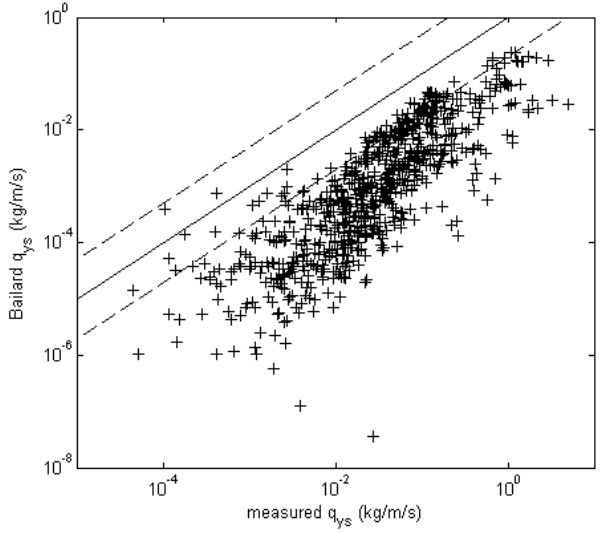
Fig. 3. Comparison of measured and predicted (using the Bailard formula) values of depth-integrated suspended sediment transport. The solid line indicates equality and the dashed lines indicate a fac- tor 5 difference between the predicted and observed values.